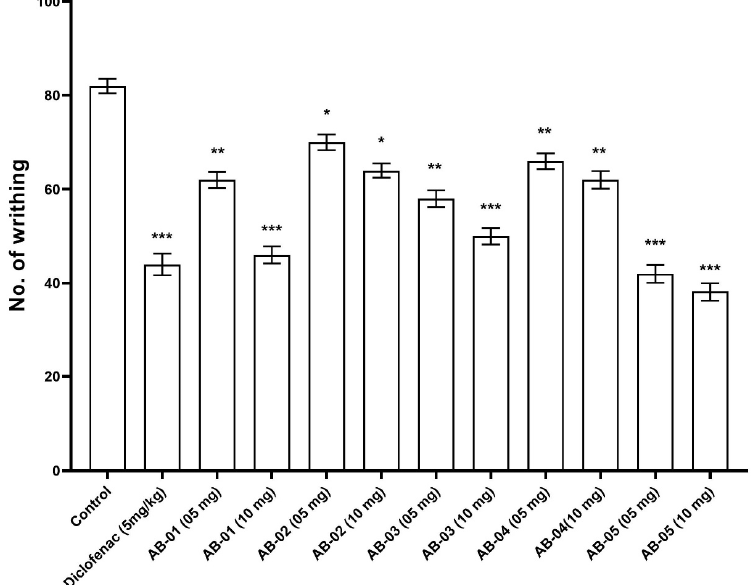
Figure 3. Effect of isolated compounds AB-01 to AB-05 and Diclofenac (Standard) on acetic acid- induced writhing in mice. Each value is presented as Mean ± S.E.M. One-way ANOVA followed by Dunnett’s test, p : * p < 0.05, ** p < 0.01 and *** p < 0.001, compared with respective control group.